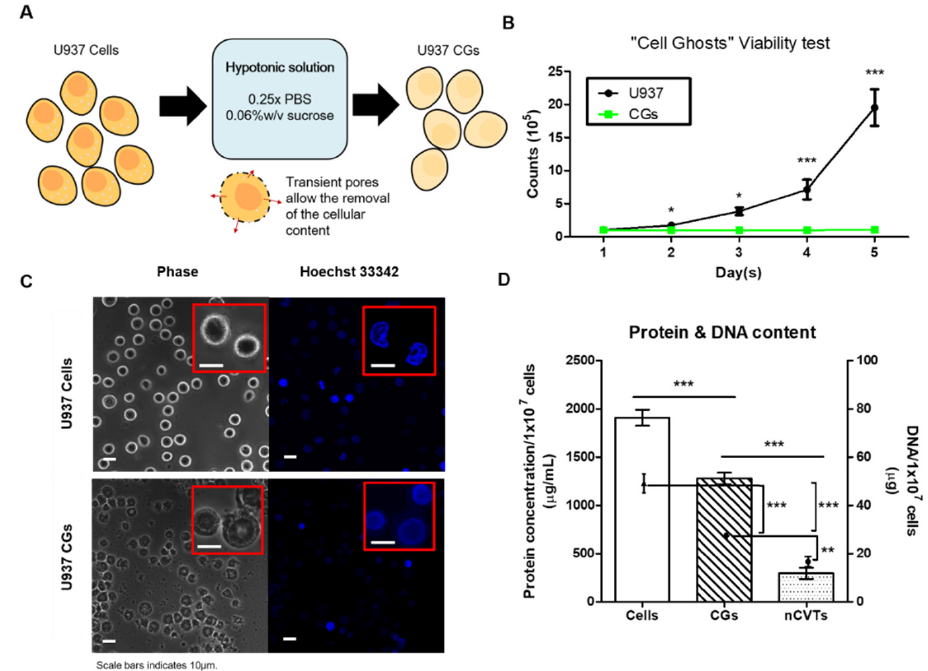
Figure 1. Production of cell ghosts (CGs) from 1 × 10 7 U937 cells. ( A ) Schematic overview of CGs’ production through hypotonic treatment. ( B ) Cell viability tests of U937, and CGs over the course of 5 days, under the culture condition. ( C ) Representative confocal microscopic images of U937 cells and CGs; insert shows the zoomed-in images of U937 or CGs. Scale bar represents 10 µ m. ( D ) Comparison of total protein and DNA concentration of cells, CGs, and nCVTs. All samples were normalized to the same starting cell or CG number of 1 × 10 7 ; ( n = 3/group) * p < 0.05, ** p < 0.01 and *** p < 0.001.